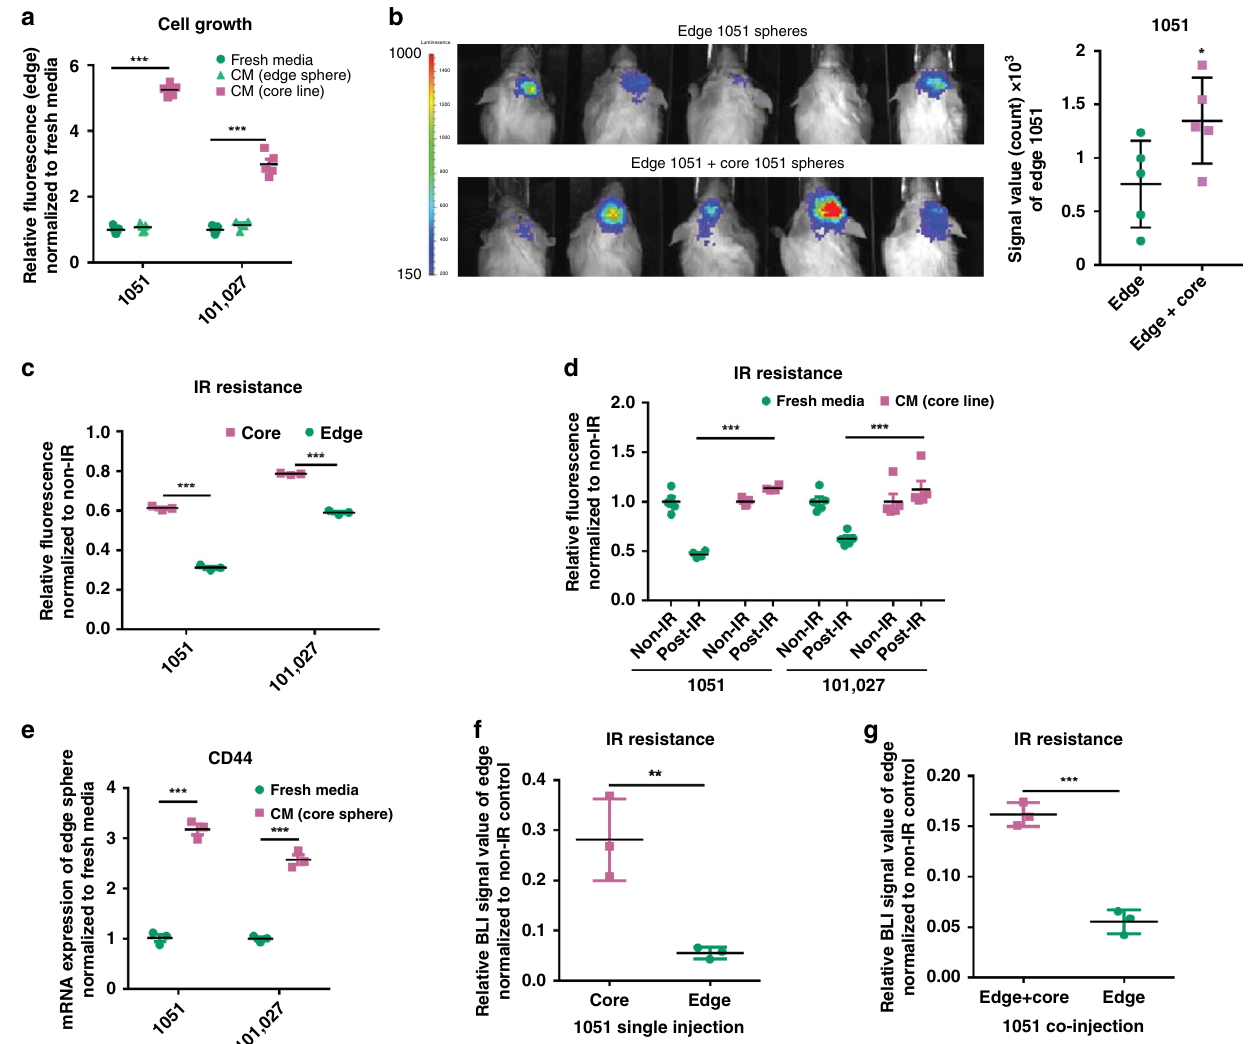
Fig. 4 Regionally speci fi ed GBM cells demonstrate a similar growth promotion effect from GBM core to edge. a In vitro cell growth assay of edge 1051 and edge 101027 GBM spheres treated with CM from core or edge spheres. n = 5 independent samples per group. b Bioluminescence imaging of mice intracranially co-injected with luciferase-labeled edge 1051 GBM spheres with or without unlabeled core 1051 GBM spheres (ratio 9:1) (left). Quanti fi cation of BLI signal in mice (right). n = 5 animals. c In vitro cell viability assay of irradiated (4 Gy; IR) or non-irradiated (non-IR) 1051 or 10127 edge and core GBM spheres. n = 3 independent samples per group. d In vitro cell viability assay of edge 1051/101027 spheres pretreated with CM from core spheres and subsequently irradiated. n = 5 independent samples per group. e qRT-PCR analysis of CD44 expression in edge 1051 and 101027 GBM spheres treated with fresh media or CM from core counterpart. n = 3 independent samples per group. f Quanti fi cation of BLI signal from mice intracranially injected with luciferase-labeled edge or core 1051 GBM spheres before and after irradiation. n = 3 animals. g Quanti fi cation of BLI signal from mice intracranially injected with luciferase-labeled 1051 cells edge alone or together with unlabeled core 1051 GBM spheres before and after irradiation. n = 3 animals. a – g Data are mean ± s.d. Signi fi cance was calculated by unpaired, two-tailed t- test with * p < 0.05; ** p < 0.01; *** p <